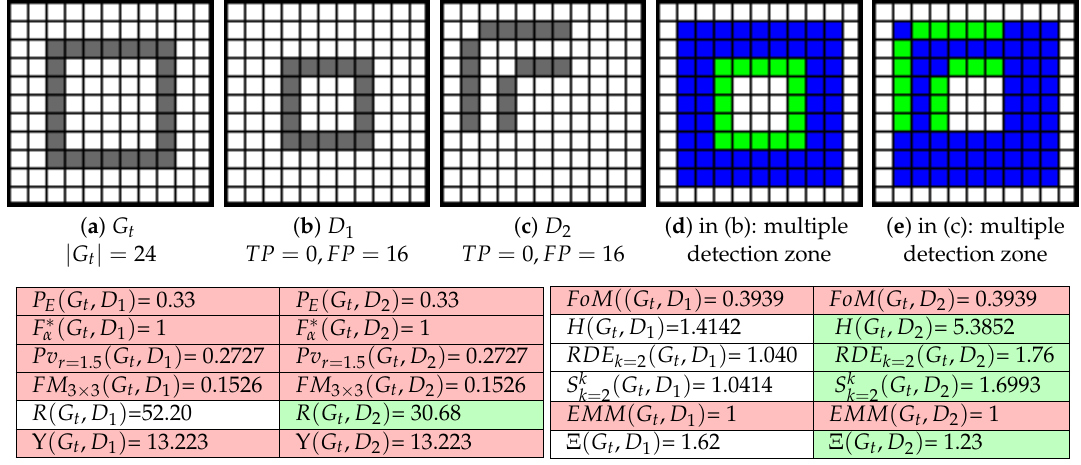
Figure 8. Different D c : number of false positive points ( FP ) and false negative points ( FN ) are the same for D 1 and for D 2 but the distances of FNs and the shapes of the two D c are different. The legend for ( d , e ) is available in Figure